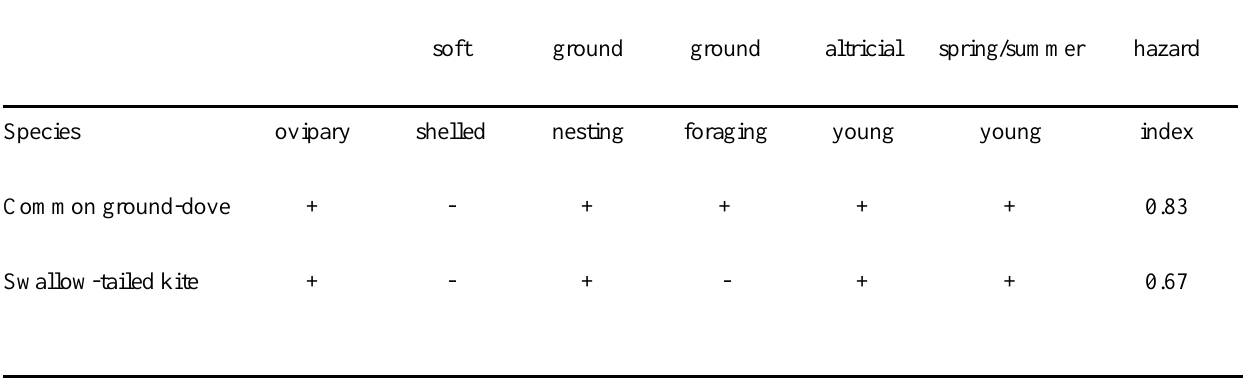
Table 2. Calculation of hazard indices based on six life-history traits that potentially increase species' vulnerability to fire ant impacts. A “+” indicates vulnerability. Hazard indices are produced by dividing the number of hazards to which targets are vulnerable by the total number of potential hazards.